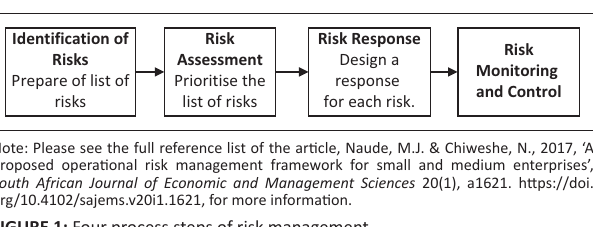
FIGURE 1: Four process steps of risk